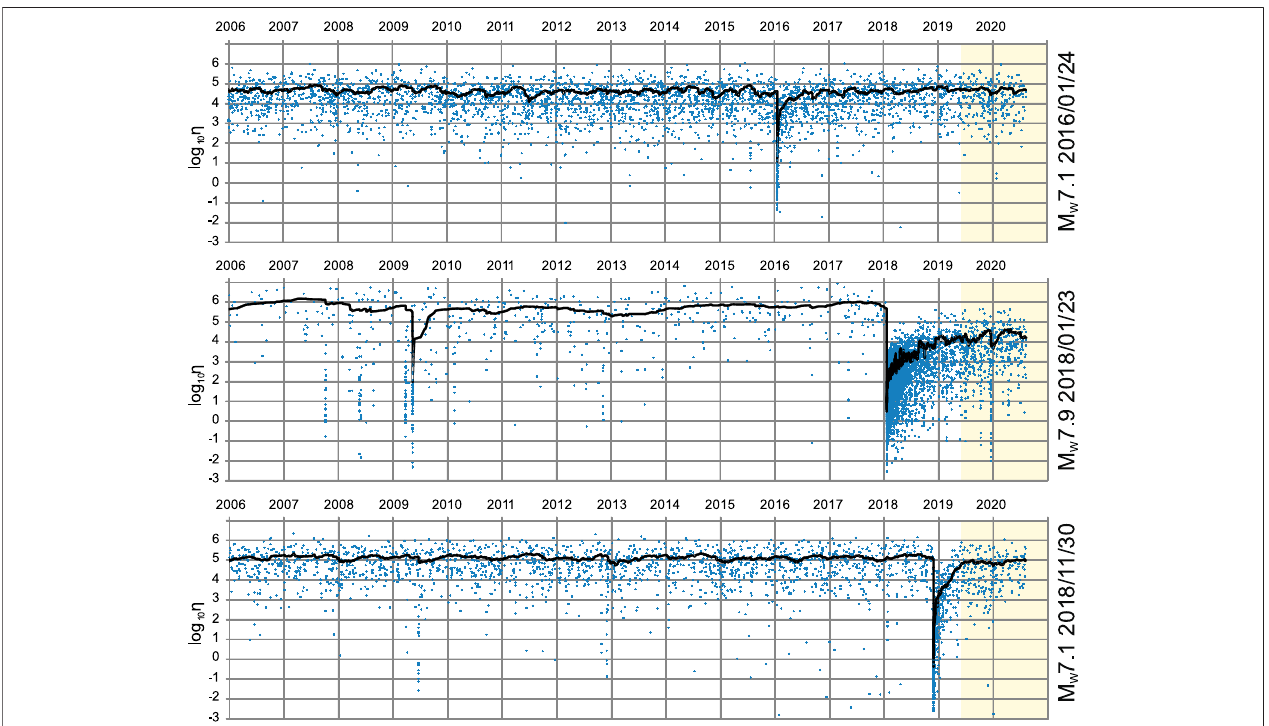
FIGURE6| ValuesoftheUSLEcontrolparameter η (littlecrosses)vs.earthquakeorigintimewithinangulardistanceof1 ° fromtheepicentersofM W 7.1January24, 2016(top)andNovember30,2018(bottom)andwithin2.5 ° fromtheepicenterofM W 7.9January23,2018(middle)mainshocksandtheiraveragesper50events(lines). An apparent rise and drop of < η > by a factor of 2 in amplitude is observed in about a year preceding the two 2018 main shocks and not before the January 24, 2016, M7.1 event.